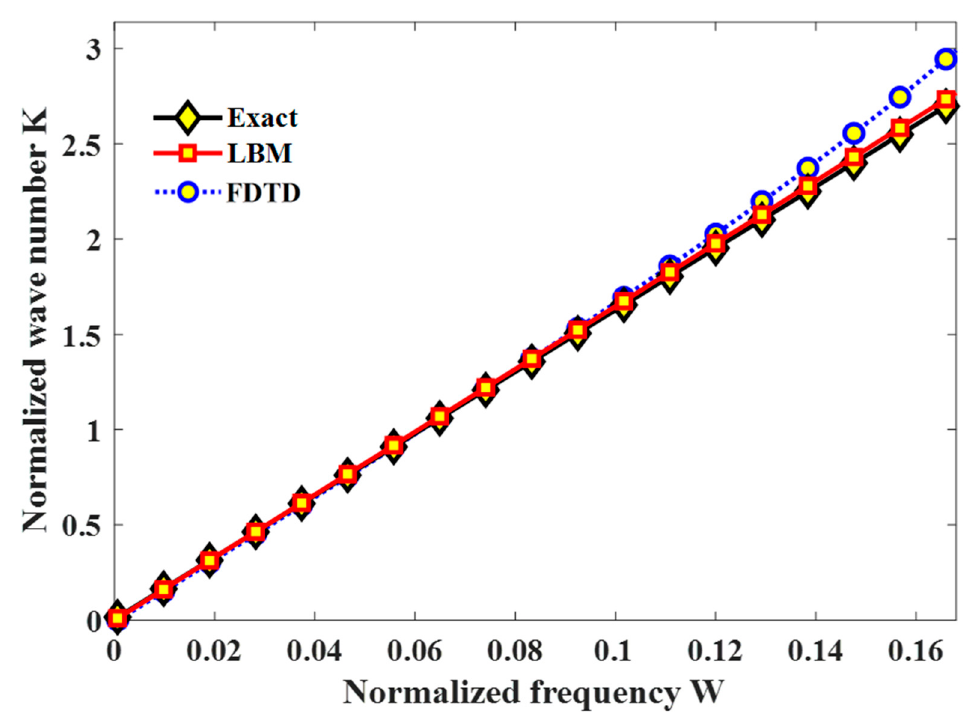
Figure 2. Comparison of dispersion relations in the FDTD and proposed LBM method in this study with the exact dispersion relation in non-dispersive media.